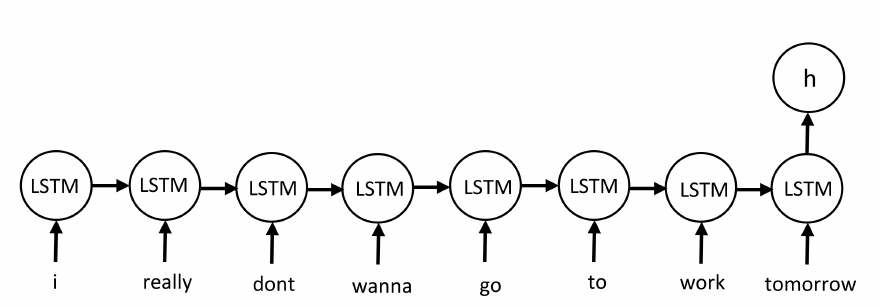
Figure 6. The sequential learning procedure of an LSTM